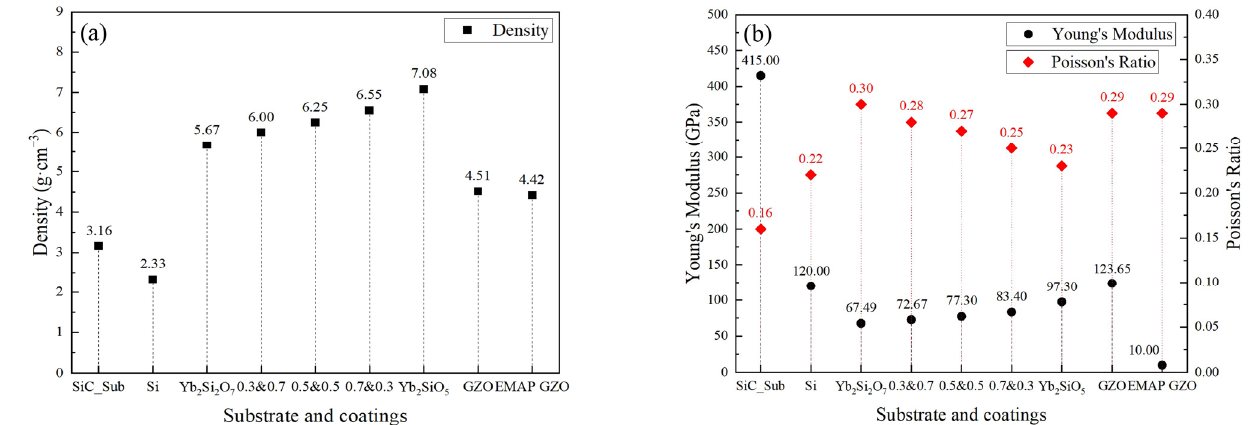
Figure 4. Distributions of density, Young’s modulus and Poisson’s ratio of materials: ( a ) density; ( b ) Young’s modulus and Poisson’s ratio.